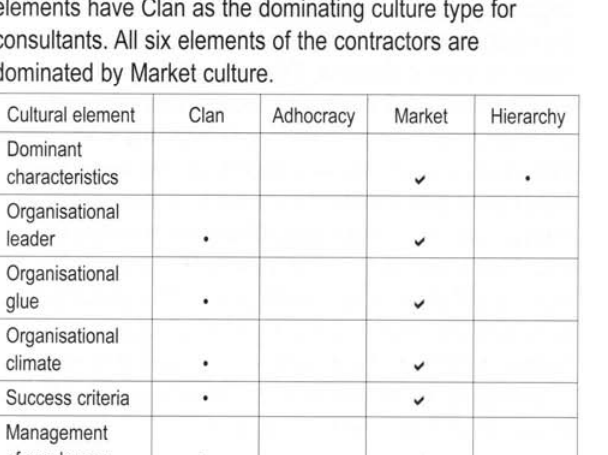
Table 1: Dominating culture type in each element of the contractor and consultant organisations